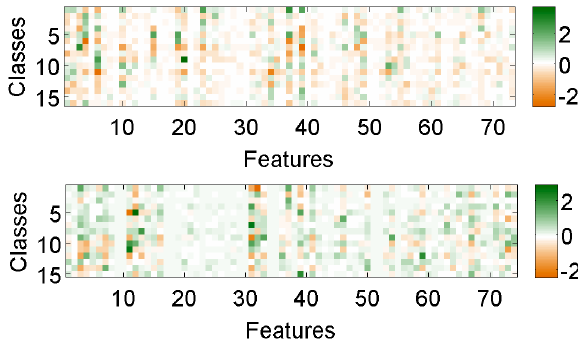
Figure 6: Final weight matrix for a run of the I NDIAN P INES 2010 (top) and H OUSTON 2013 (bottom)